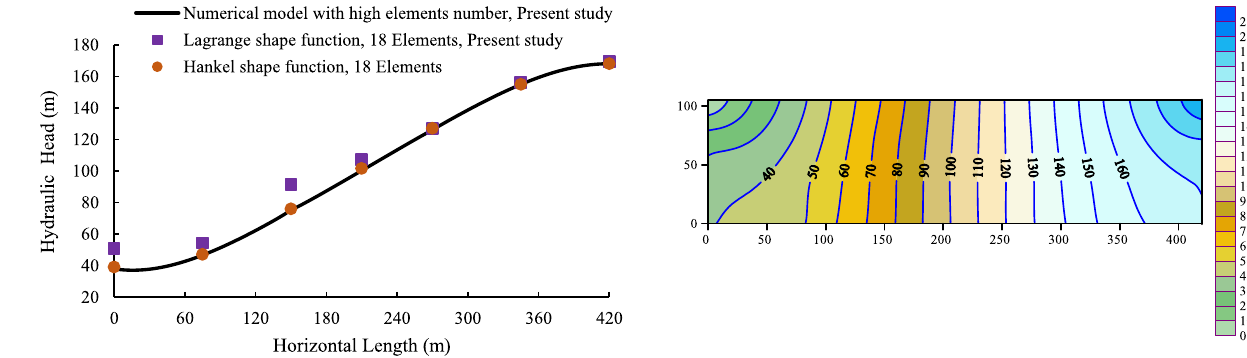
Fig. 17 Comparison of hydraulic head results at y = 0, among Hankel shape function (18 elements) and Lagrange shape function (18 and 4900 elements) for the fourth problem